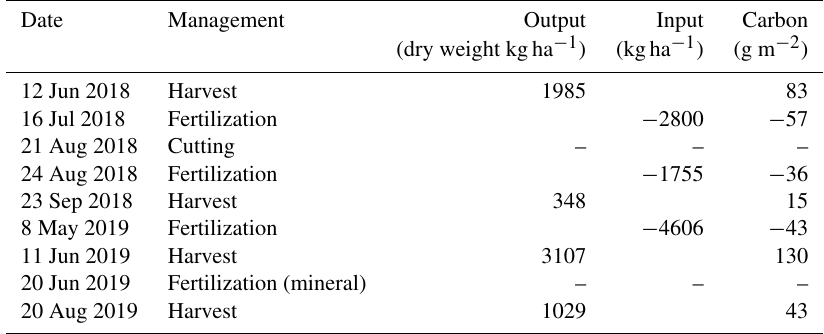
Figure 1. Experimental field with the sectors representing the target area that covers 3.9ha. Eddy covariance tower is located in the centre of the sectors. EC data from wind directions from 30 to 140 ◦ were discarded due to another experimental plot located in that part of the field. (Orthophoto from National Land Survey of Finland.) Table 1. Different management events and their C inputs (fertilization) and C outputs (harvest). During the cutting in August 2018, the grass was not collected and thus did not result in any C flux allocated to